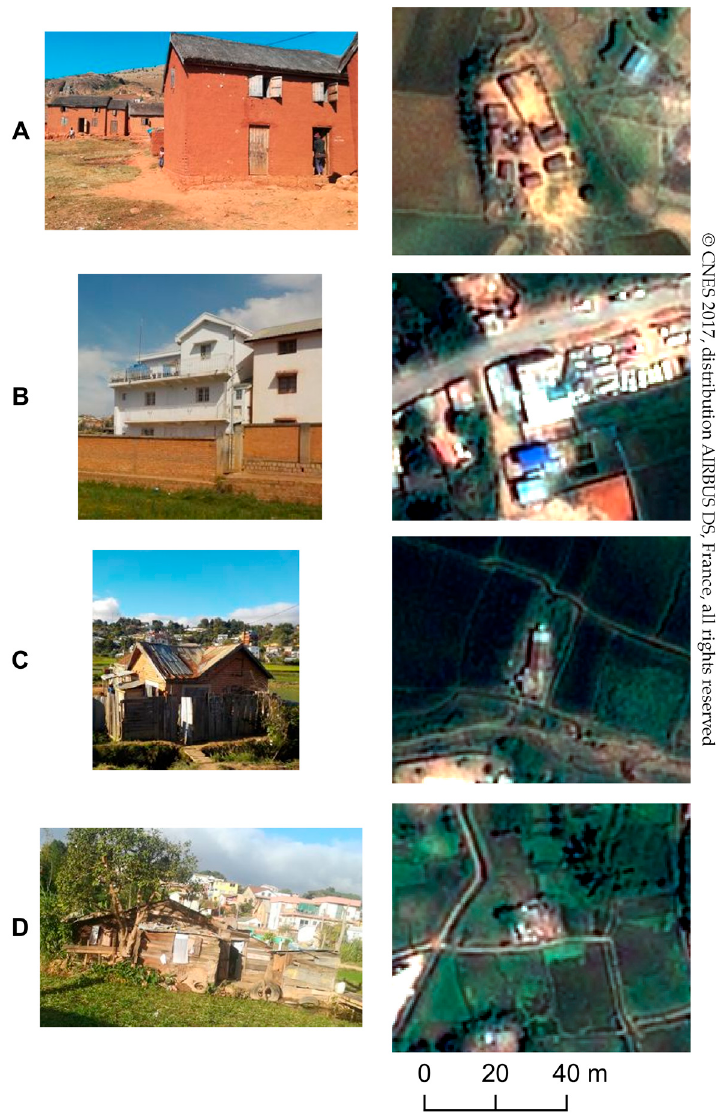
Figure 4. Field photographs (left) and the corresponding satellite Pleiades images (right) of urban classes: rural housing (A), residential area (B), and mixed habitat (C, D).